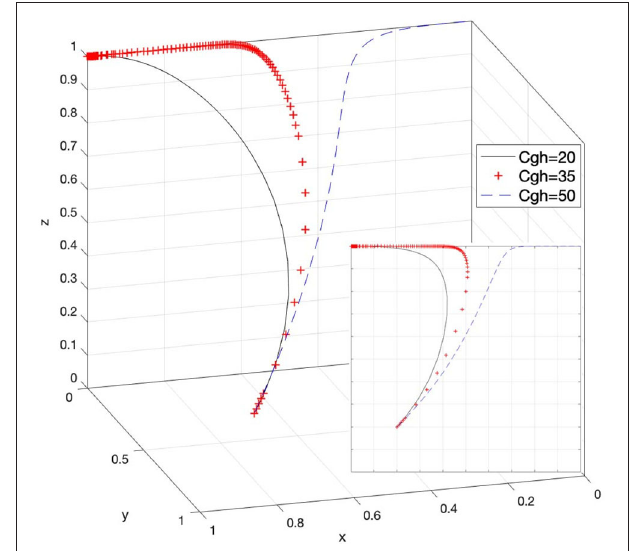
FIGURE 14 | Effect of the superior authority’s penalties for the government. FIGURE 15 | Effect of the response cost on the government when rights